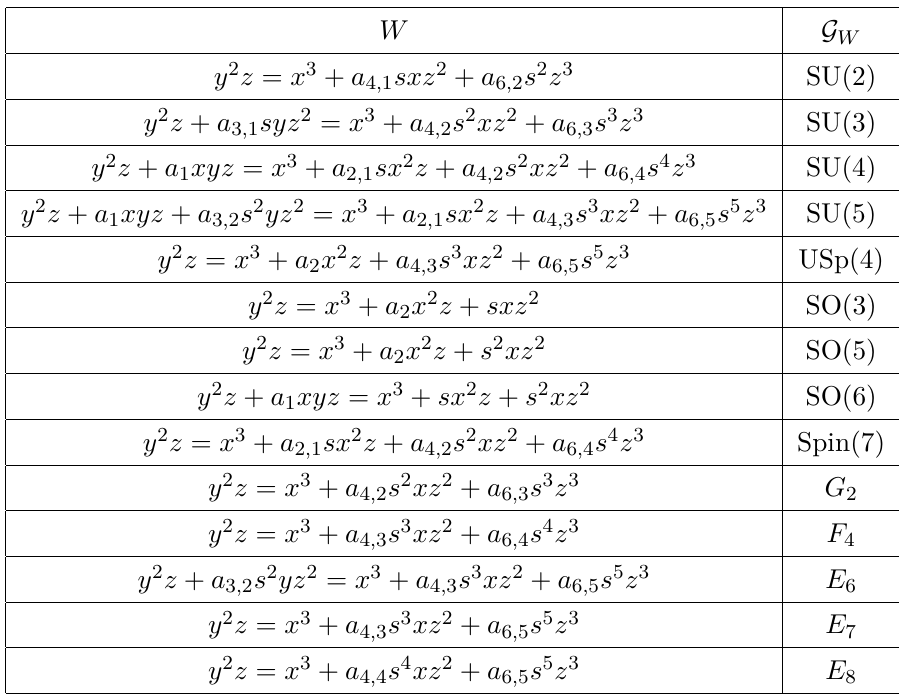
Table 1 . Equations for the anti-canonical Weierstrass fibrations under